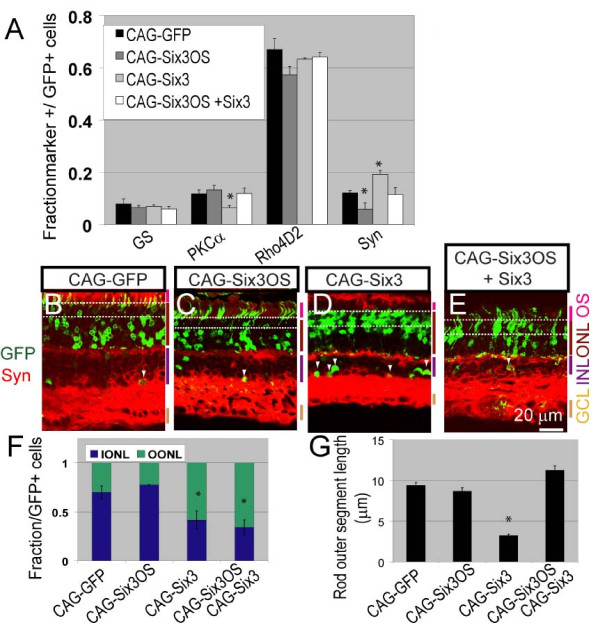
Overexpression of Six3OS in developing retina inhibits changes in cell fate and photoreceptor morphology observed following Six3 overexpression. (A) Electroporation of CAG-Six3 led to an increase in the fraction of GFP-positive cells expressing the amacrine cell marker syntaxin and a decrease in cells expressing the rod bipolar marker PKCα, CAG-Six3OS led to a decrease in syntaxin-positive cells, and co-expression led to a cell composition that was indistinguishable from CAG-GFP controls. *P < 0.05. (B-E) Section immunohistochemistry of retinas electroporated with CAG-GFP, CAG-Six3OS, CAG-Six3 or both CAG-Six3OS and CAG-Six3. White dashed lines define the outer third of the outer nuclear layer (OONL). Syntaxin (red) is co-immunostained with GFP (green). (C) No obvious difference is observed in either amacrine cell number or morphology (white arrowheads) in retinas electroporated with CAG-Six3OS relative to CAG-GFP controls or in the fraction of the cells in the OONL. (D) An increase in amacrine cell number and in the number of cells in the OONL and a decrease in outer segment length is observed in the case of Six3. (E) An increase in the number of cells in the OONL is observed, but no difference in amacrine cell number or outer segment length is observed from controls following co-electroporation of CAG-Six3 and CAG-Six3OS. GCL, ganglion cell layer; INL, inner nuclear layer; ONL, outer nuclear layer; OS, outer segment.. (F) Laminar position of cells within the OONL. Electroporation of CAG-Six3 leads to a shift of rod photoreceptor cell bodies to the OONL, and this effect is not affected by co-electroporation of CAG-Six3OS (white dashed lines in B-E). (G) Rod photoreceptors electroporated with CAG-Six3 show substantially shorter outer segments and this effect is reversed by co-electroporation with CAG-Six3OS. Cell type specific markers used: rhodopsin (Rho4D2), rod photoreceptors; glutamine synthetase (GS), Muller glia; protein kinase C alpha (PKCα), rod bipolar cells; syntaxin (Syn), amacrine cells.